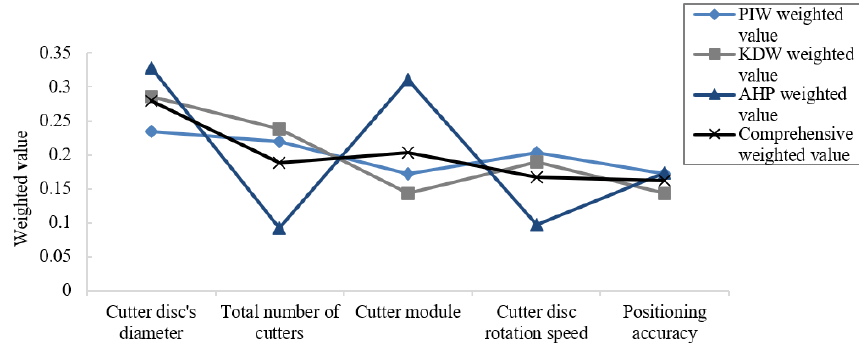
Figure 8. Comparison of the attribute weighted values calculated by the four